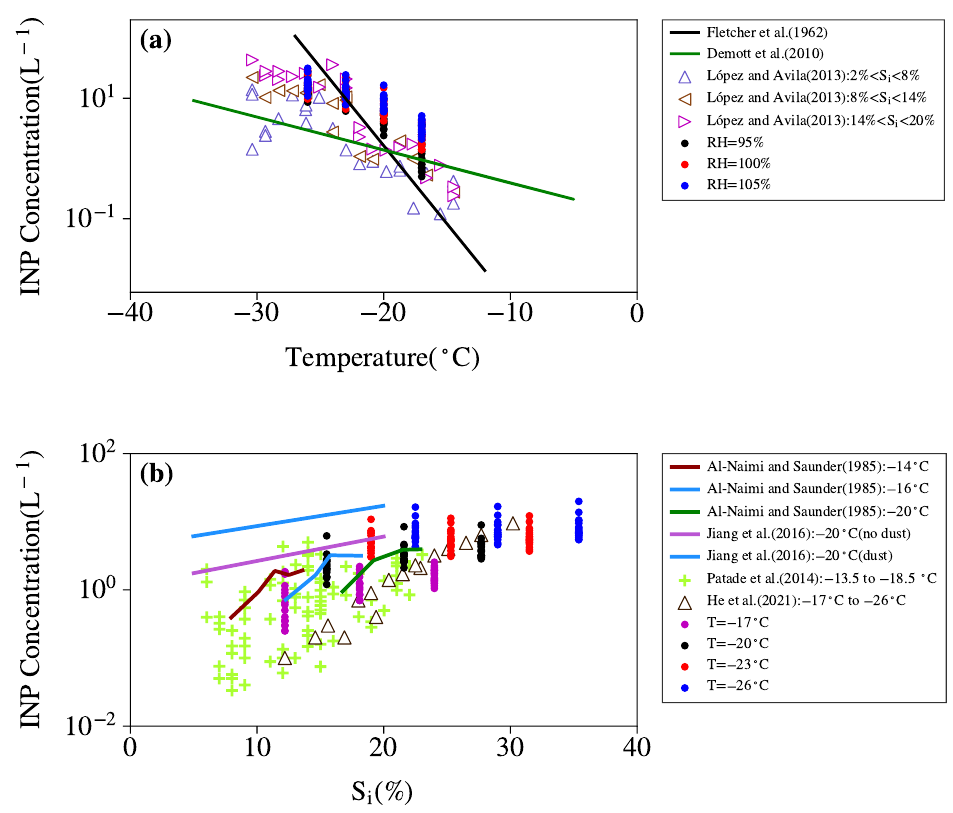
Figure 4. ( a ) The variations of INP concentration with temperature at different relative humidity. ( b ) The variations of INP concentration with relative humidity at different temperature. Some of the results obtained in previous studies are also shown for comparison